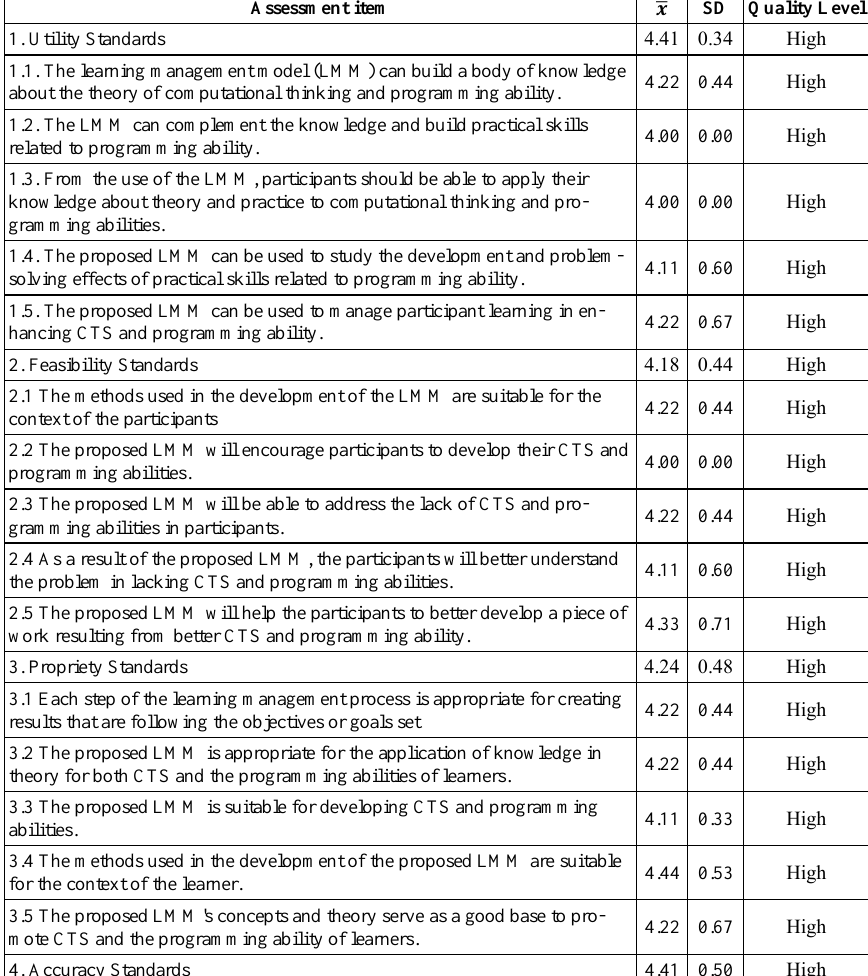
Table 1. Appropriateness of an integrated DBLMM to promote CTS and programming ability of students through